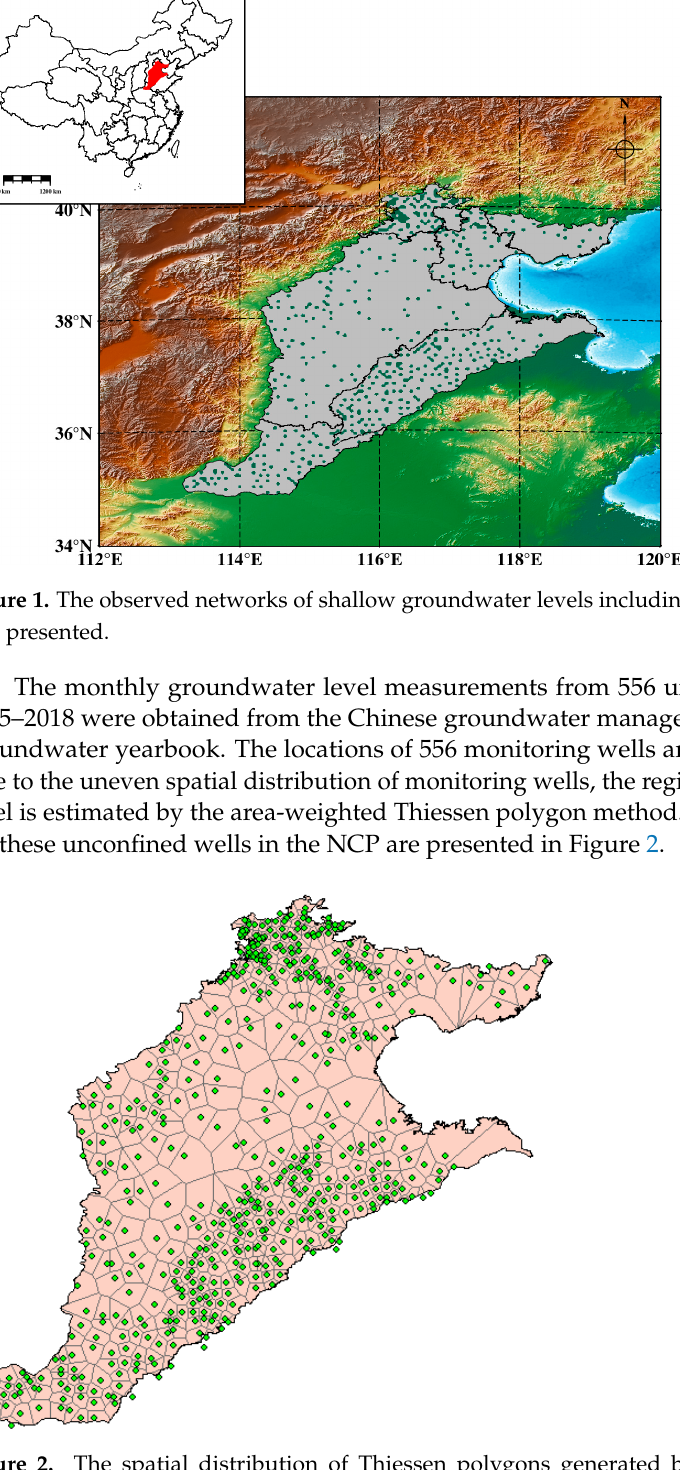
Figure 2. The spatial distribution of Thiessen polygons generated by the location records of 556 unconfined wells.